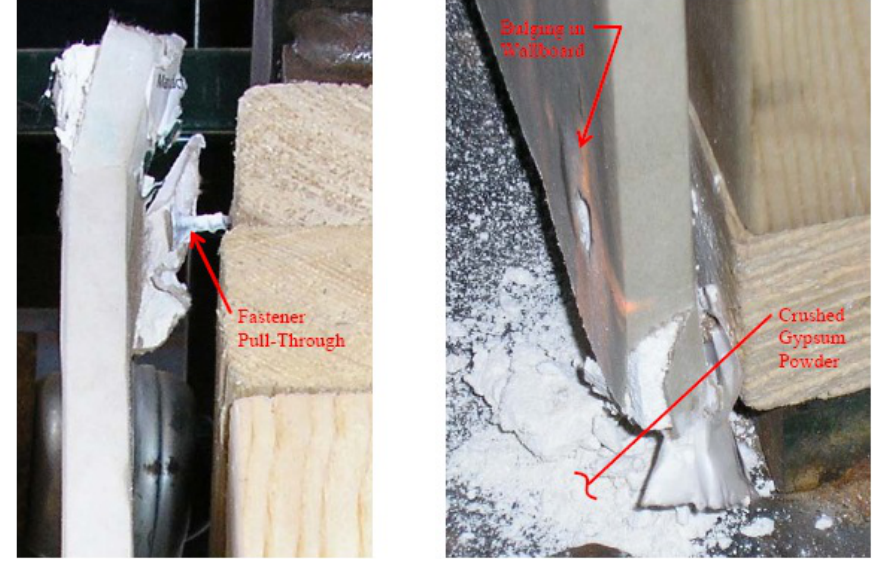
Figure 18. Typical Damage to Gypsum Sheathing